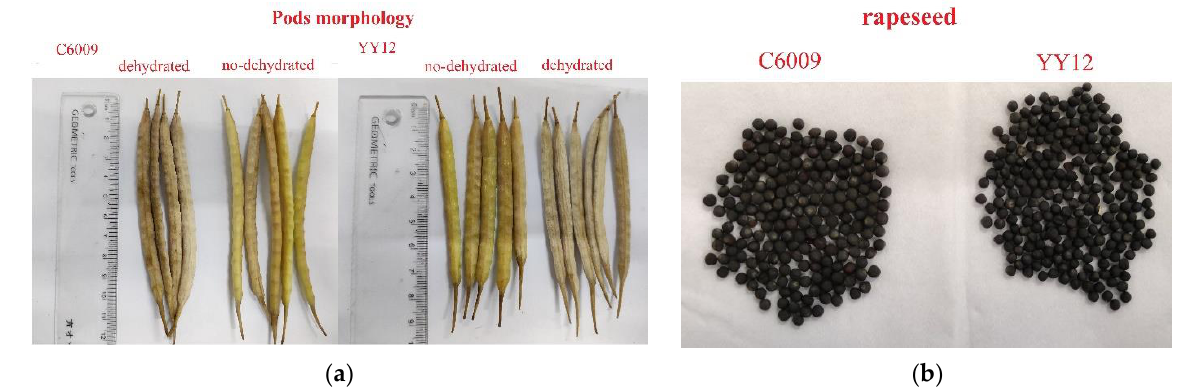
Figure 4. Comparison of morphology of the dehydrated and non-dehydrated pods and rapeseeds of C6009 and YY12. ( a ) Comparison of pods morphology. ( b ) Comparison of seeds morphology. Table 2. Field combine harvest comparison test of screened variety C6009 and control variety YY12 in 2020 in Yangzhou. Different lowercase letters in a column correspond to significantly different values at the level of 0.05.